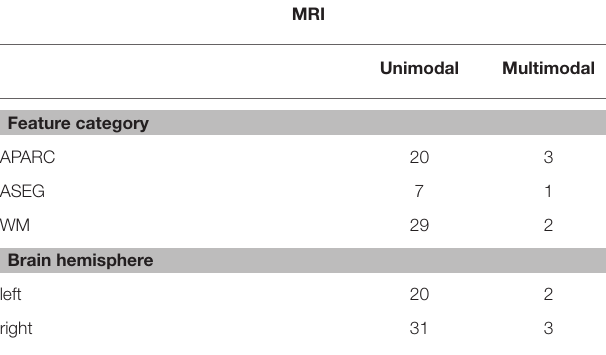
TABLE 4 | Distribution of the selected features that were selected in multiple runs for EEG groups. EEG